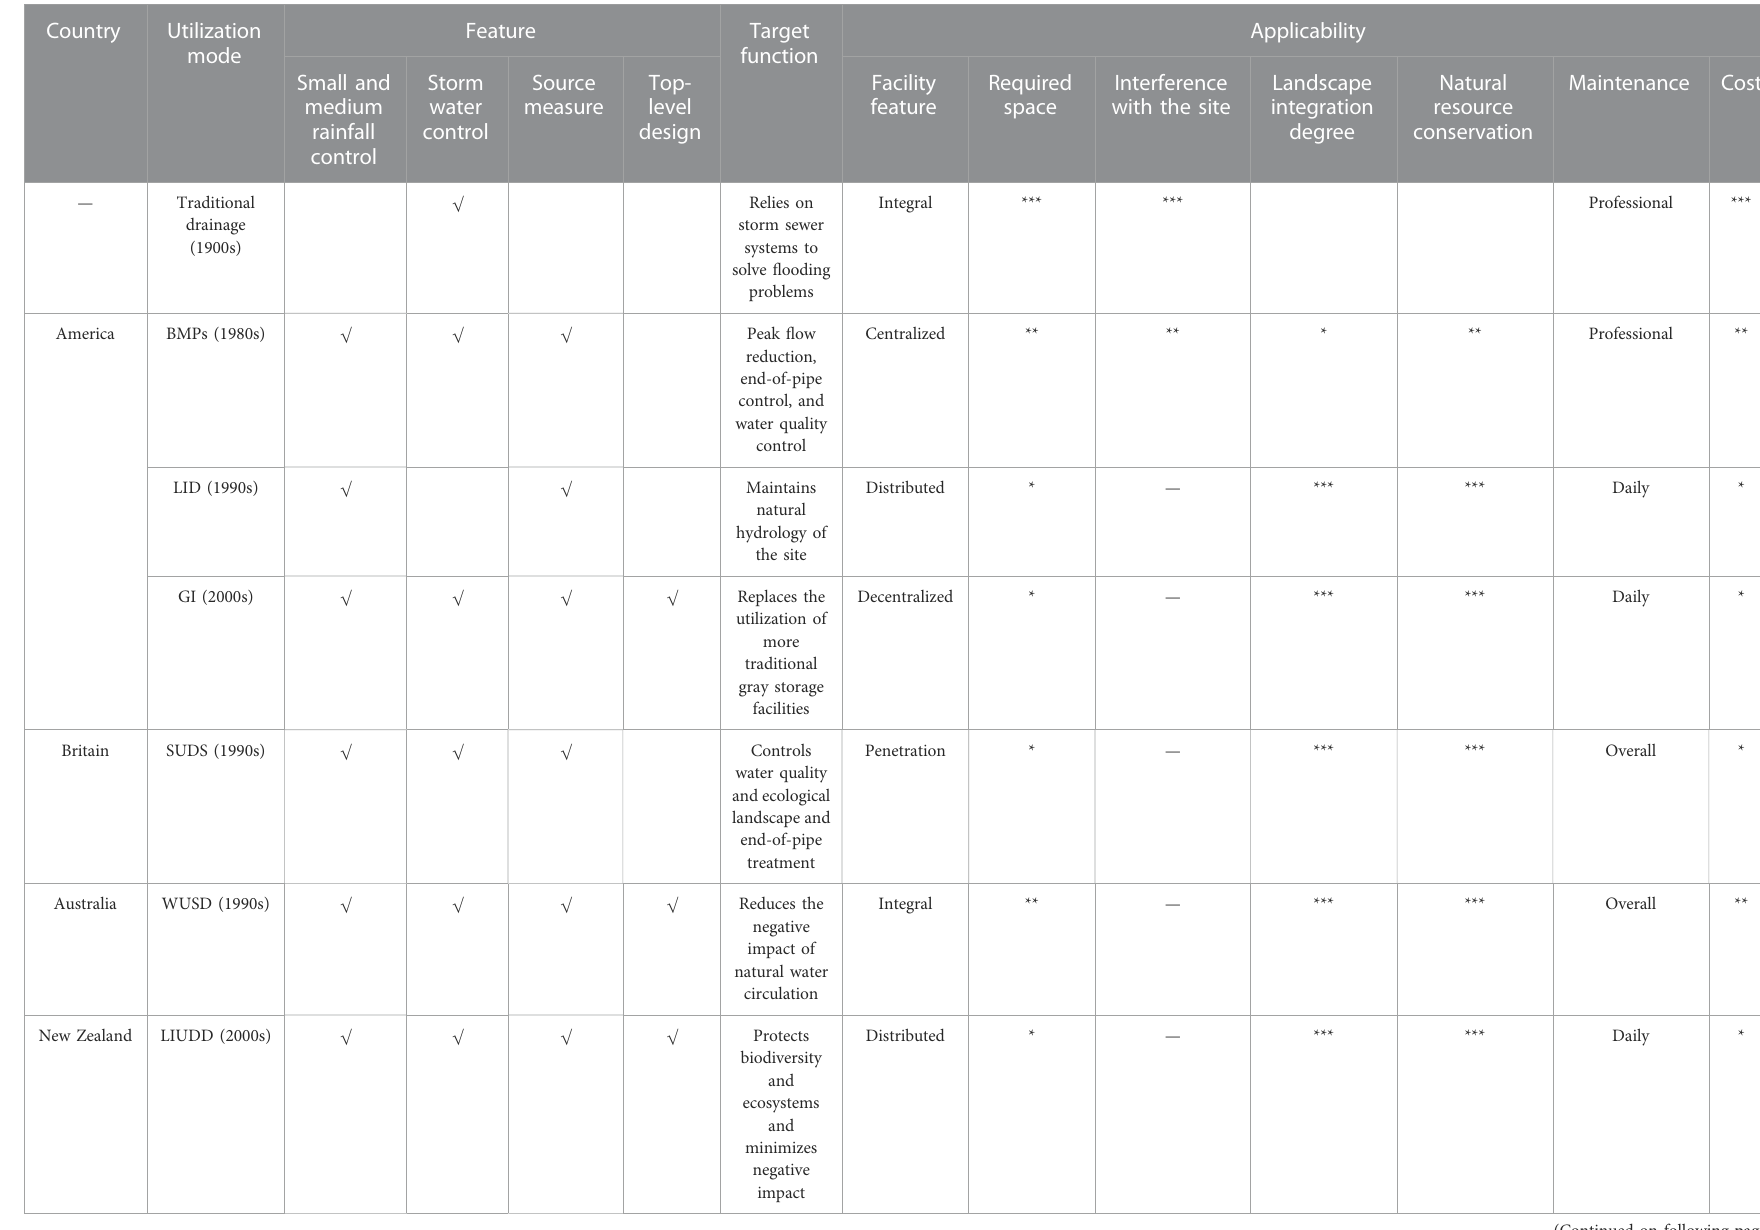
TABLE 1 Comparison of typical rainwater utilization